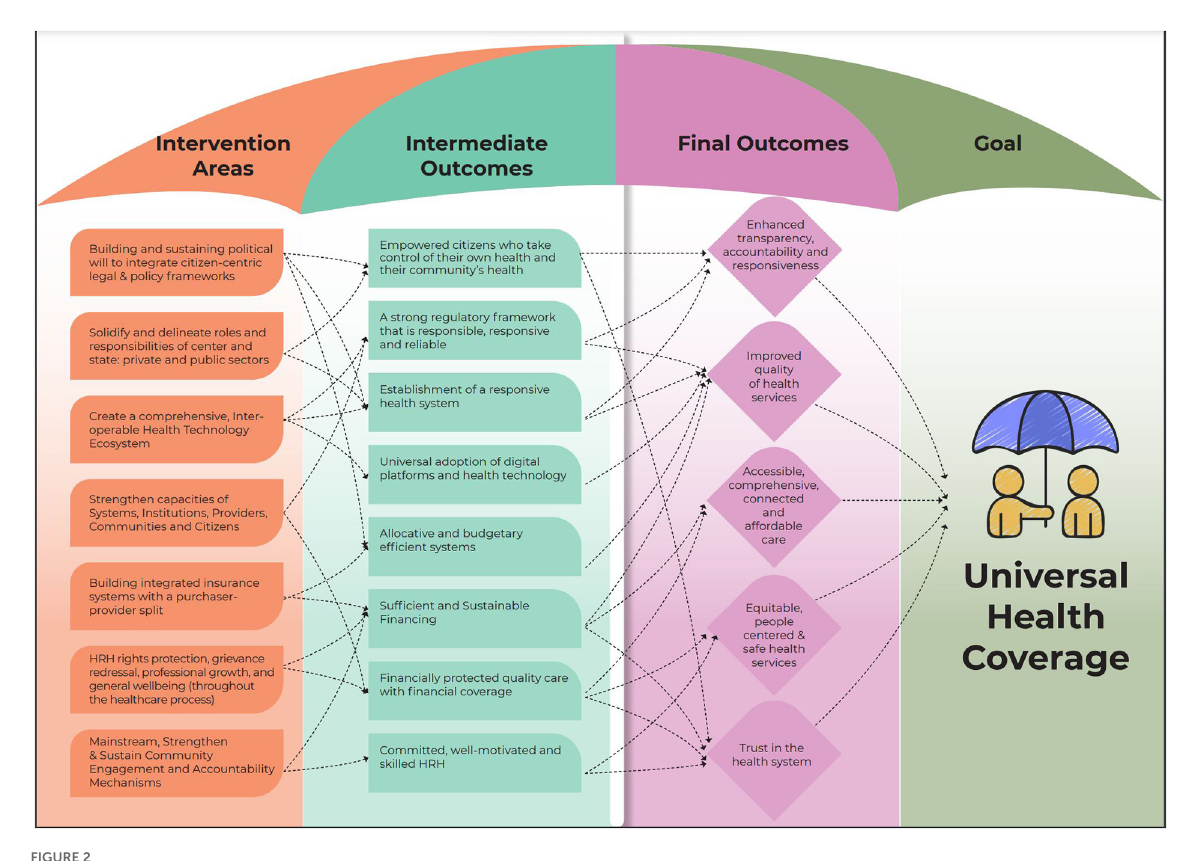
FIGURE2 Cross-sectoral ToC Map to achieve